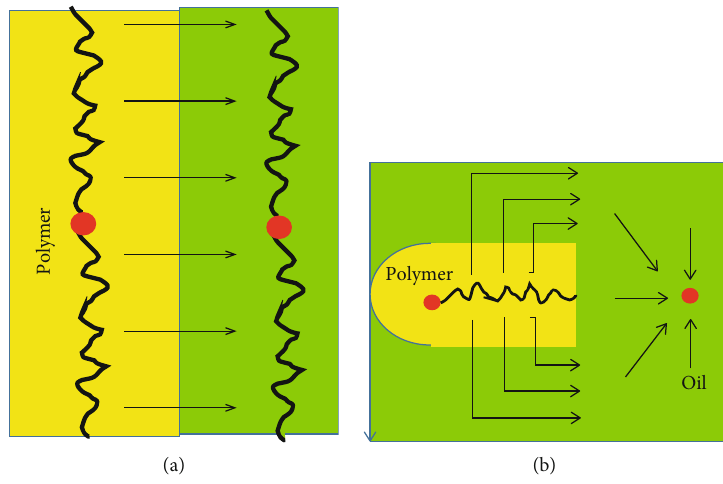
Figure 4: Illustration of e ff ect of fracture